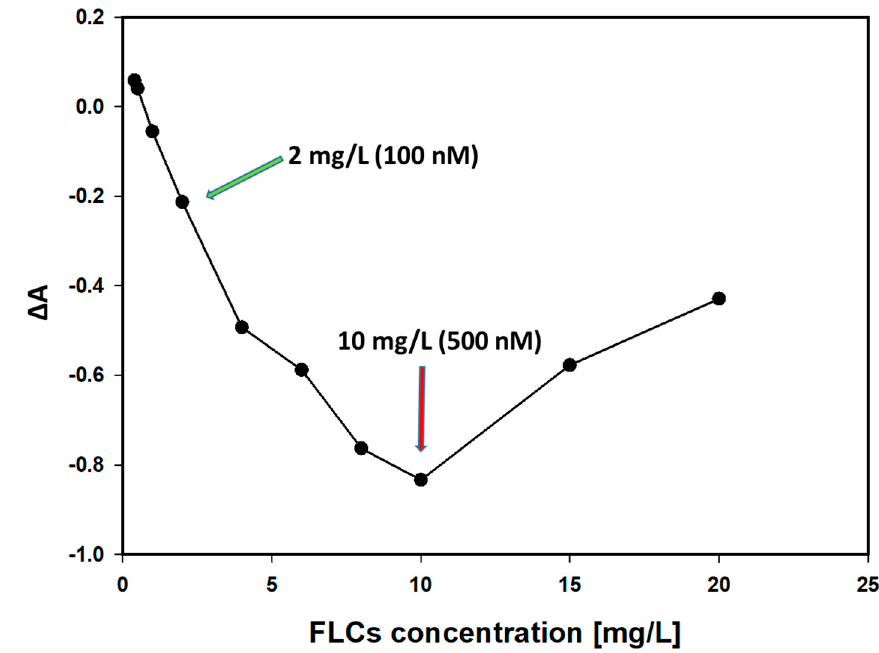
Figure 9. Changes in the absorbance of antibody-coated nanoparticles (10 nM), with the maximum LSPR (395 nm) and increasing FLCs concentrations. The biggest changes were observed at a FLCs concentration of 10 mg/L (500 nM).